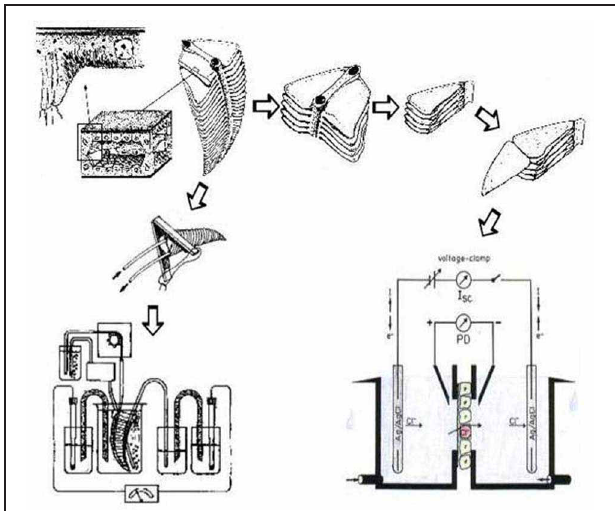
FIGURE 2 | The basic anatomical features of a crab gill (upper left), how isolated gills can be prepared and mounted for the measurement of transepithelial voltage and/or flues (lower left), and how crab gill lamellae are isolated and split for measurements in modified Ussing chambers (right). Modified after Onken and Riestenpatt (1998) and Siebers et al.